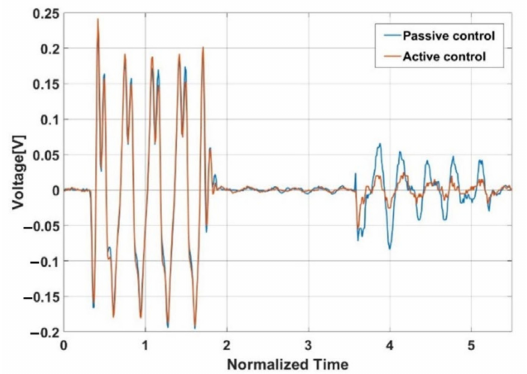
Figure 12. Reflection wave cancellation experiment